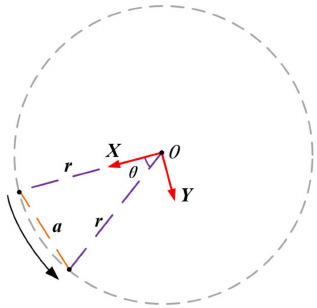
Figure 3. Projection of the double linkage on the XOY plane.